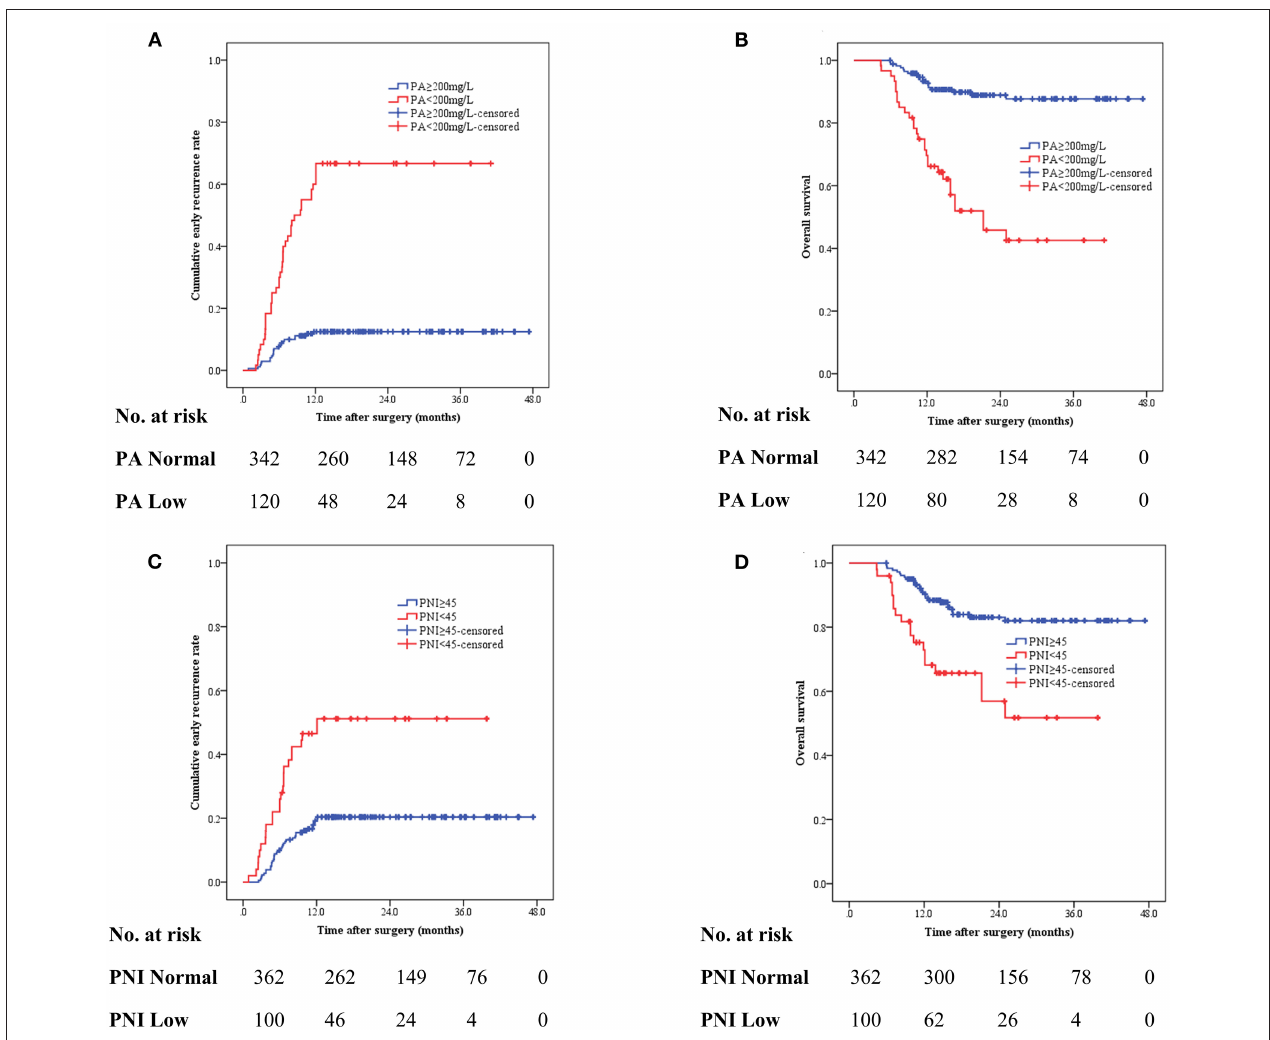
FIGURE 2 | The cumulative recurrence rate and overall survival (OS) in gastric cancer patients based on preoperative serum prealbumin level (A,B) and preoperative PNI ( < 45 vs. ≥ 45) (C,D) .